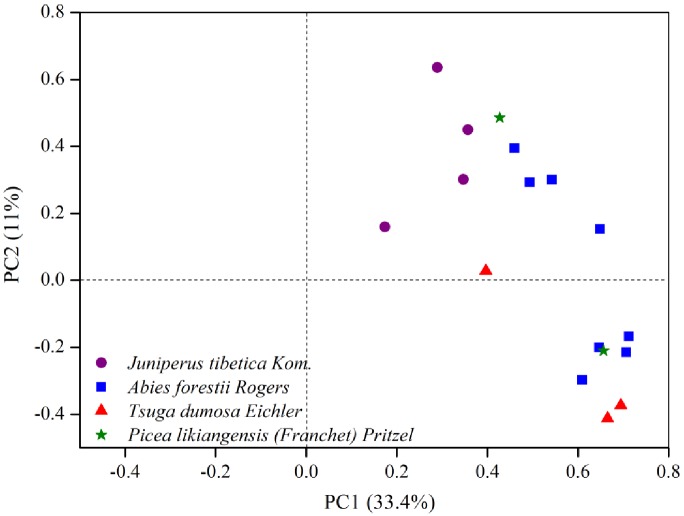
Scatter plot of the principal component (PC) loadings of the tree-ring chronology network for the common period 1825–2005 Tree species symbols as in Fig 1.